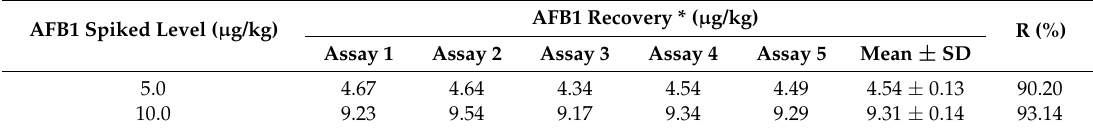
Table 2. Recovery of aflatoxin B 1 in artificially contaminated (spiked) chicken liver. AFB1 Spiked Level ( µ